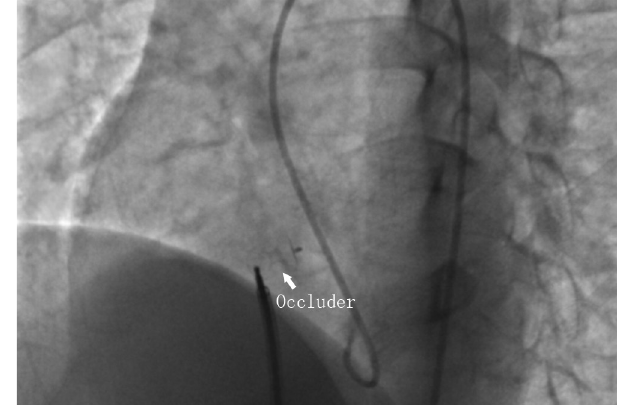
Fig. 4 – Final image showing after both discs (arrow) were deployed in group B patient.